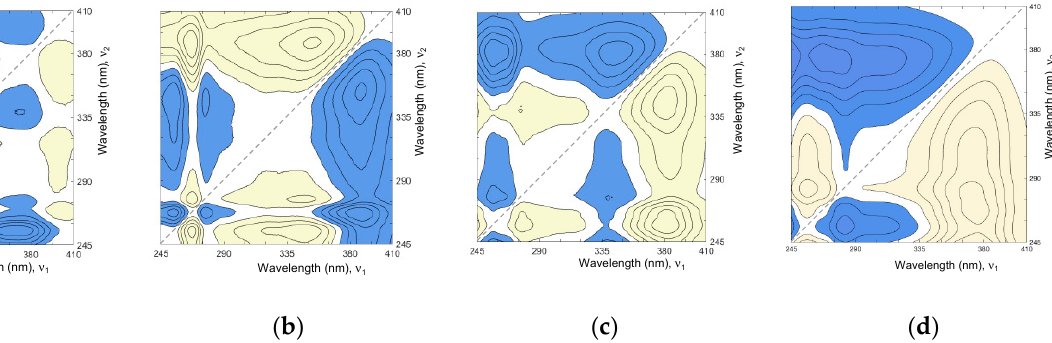
Figure 5. Asynchronous 2T2D correlation spectra of flavonoids kaempferol ( a ), quercetin ( b ), rutin ( c ), and ginkgo reference material ( d ) vs. the averaged spectrum of these three flavonoids.